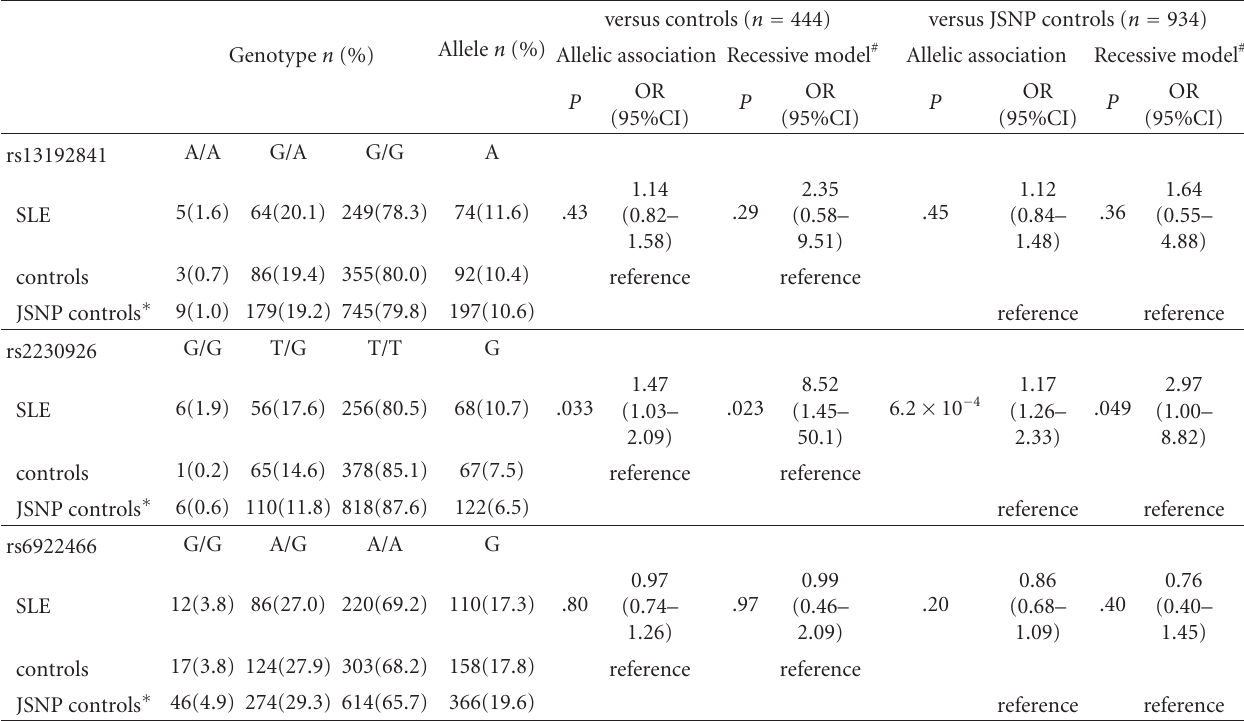
Table 1: Association of the TNFAIP3 region SNPs with SLE in a Japanese